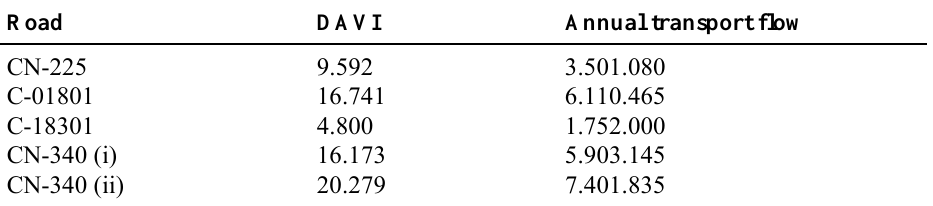
Table 5. Transport flows on the A and B roads near the new motorway